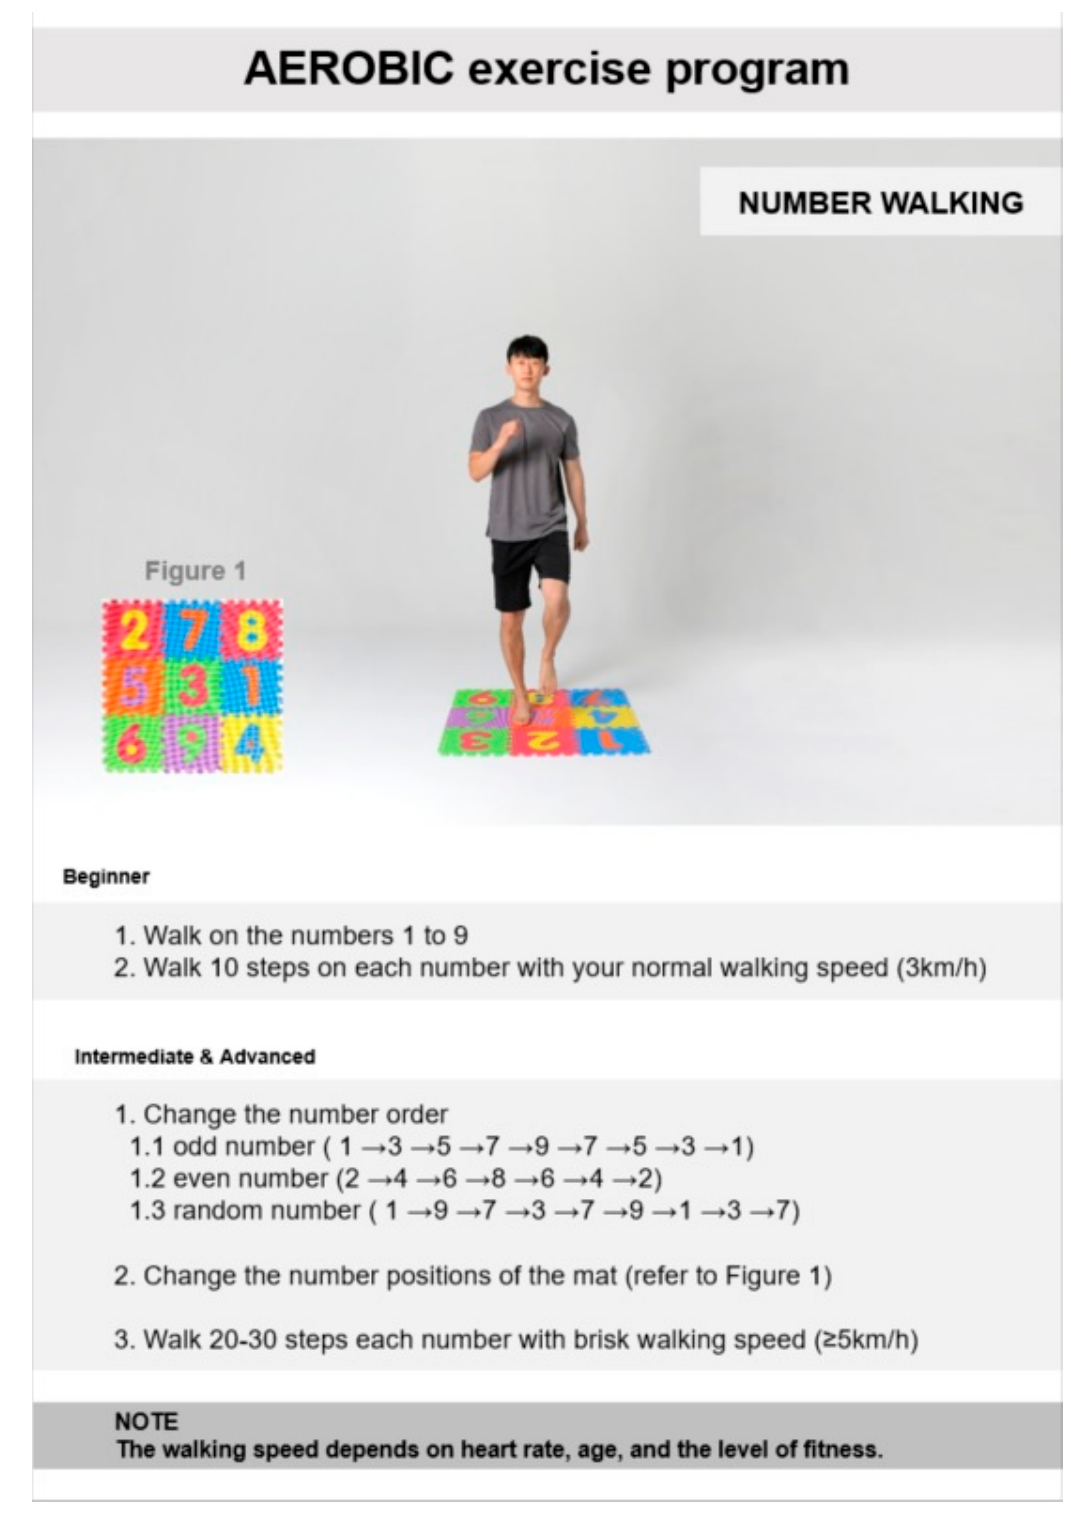
Figure A1. Detailed description and components of each movement in the “Number walking” aerobic exercise.